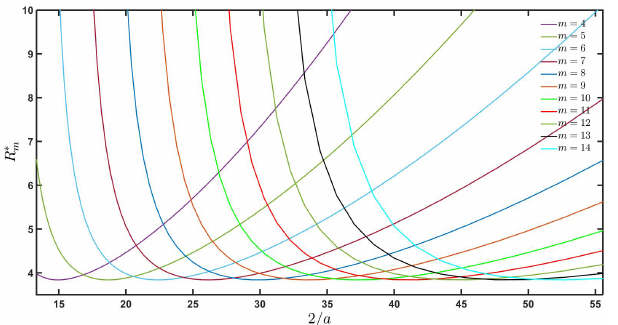
Figure 2. Marginal stability curves R ∗ m (a) obtained from the con- straint on the eigenvalue (cid:60) ρ m, 1 (R) = 0 for a range of the aspect ratio 0 . 1 ≤ a ≤ 0 .